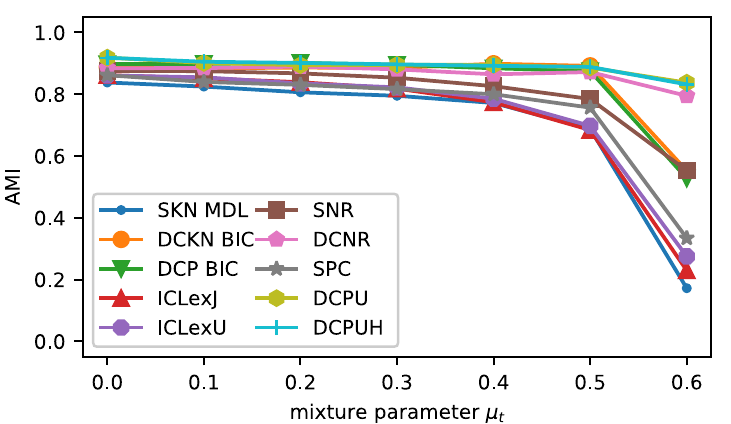
Fig 17. Results of LFR benchmark using model selection. Like before, we used 10 network instances for each μ each network and each SBM variant we executed the MHA 250k 10 times for each μ t = 0, 0.1, ... , 0.6. Then we considered one execution for each network for all number of groups K 2 {1, ... , 30} as one unit and executed the model selection based on these results. Therefore, a data point is the average of 100 AMI values resulting from 10 networks and 10 selected partitions. For the classic models only the best model selection according to Table 3 is shown.